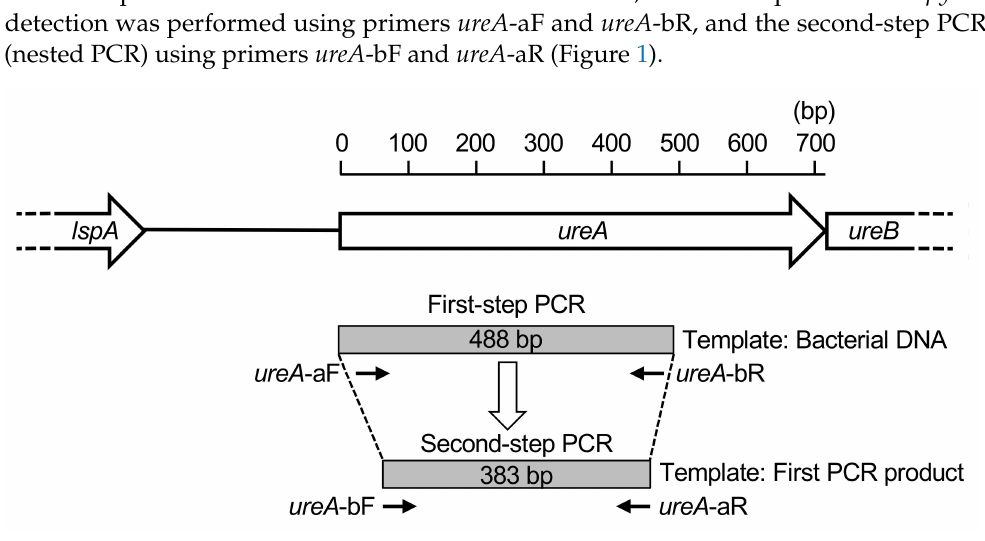
Figure 1. Schematic diagram of positions of the designed primers for Helicobacter pylori